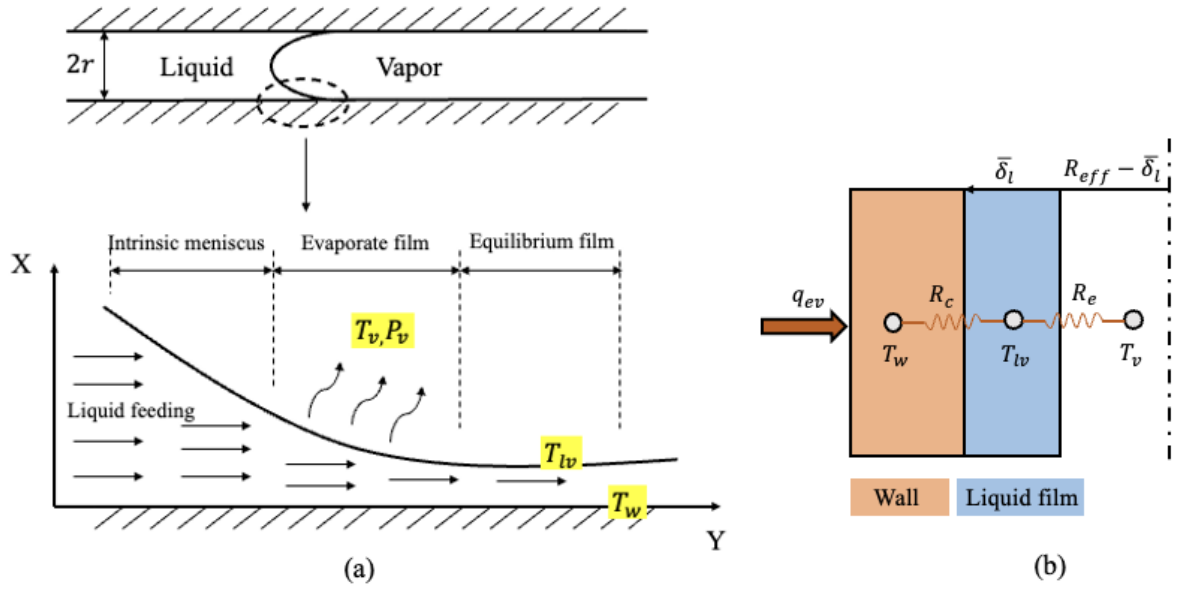
Figure 8. Extended meniscus for film evaporation in pore scale. ( a ) Extended film region close to the liquid–vapor interface. ( b ) A schematic diagram of the resistance for heat transfer by conduction across the liquid film and evaporation from the liquid–vapor interface.